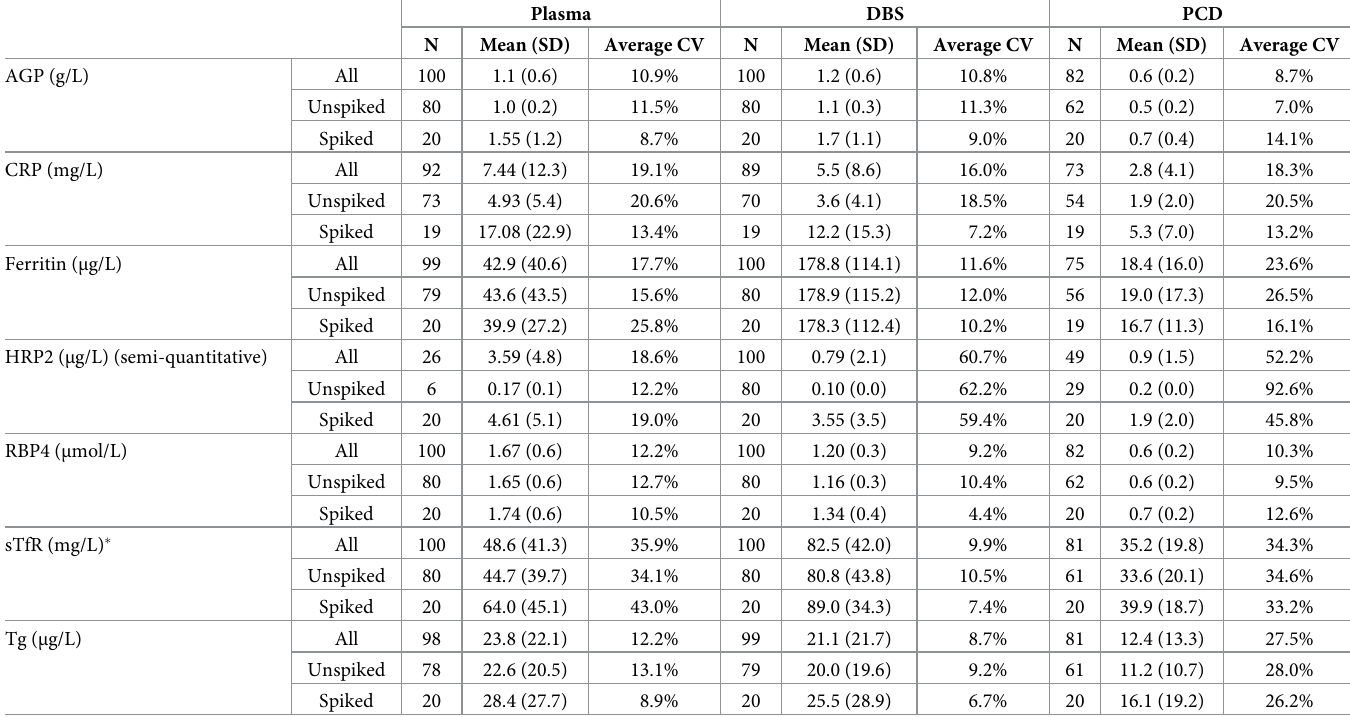
Table 2. Summary statistics and cross-laboratory coefficients of variation (CV) for plasma, DBS and PCD. Plasma